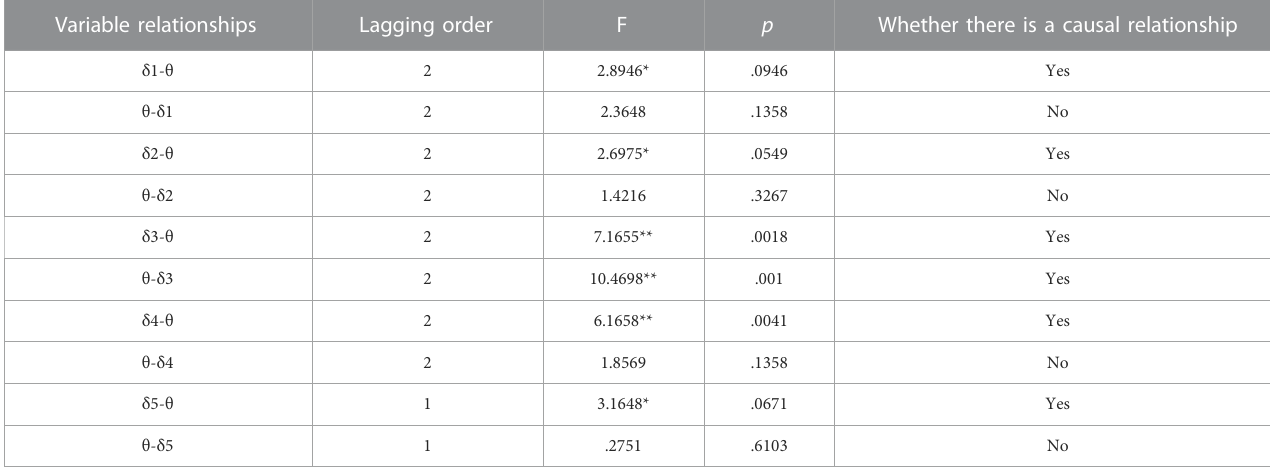
TABLE 2 Linear granger causality test results. Variable